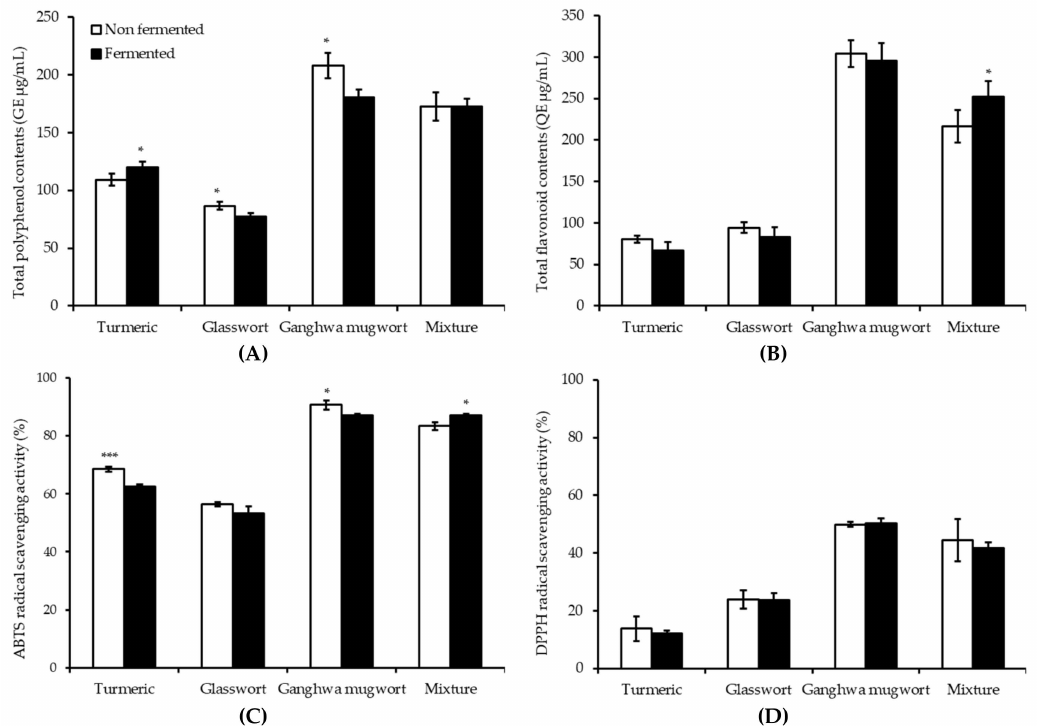
Figure 2. ( A ) Total polyphenol contents (gallic acid equivalent (GE) µ g / mL), ( B ) total